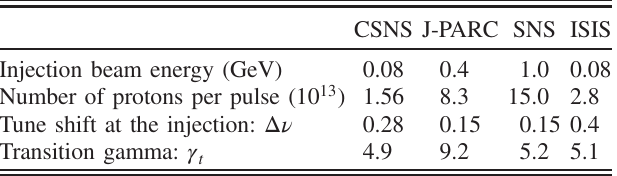
TABLE I. Related parameters of the space-charge forces for different